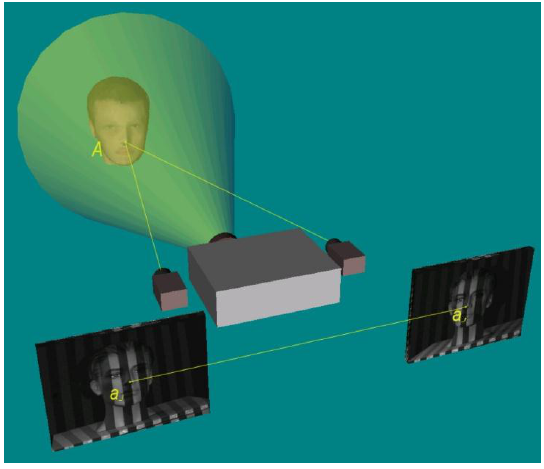
Figure 2. Measurement technique